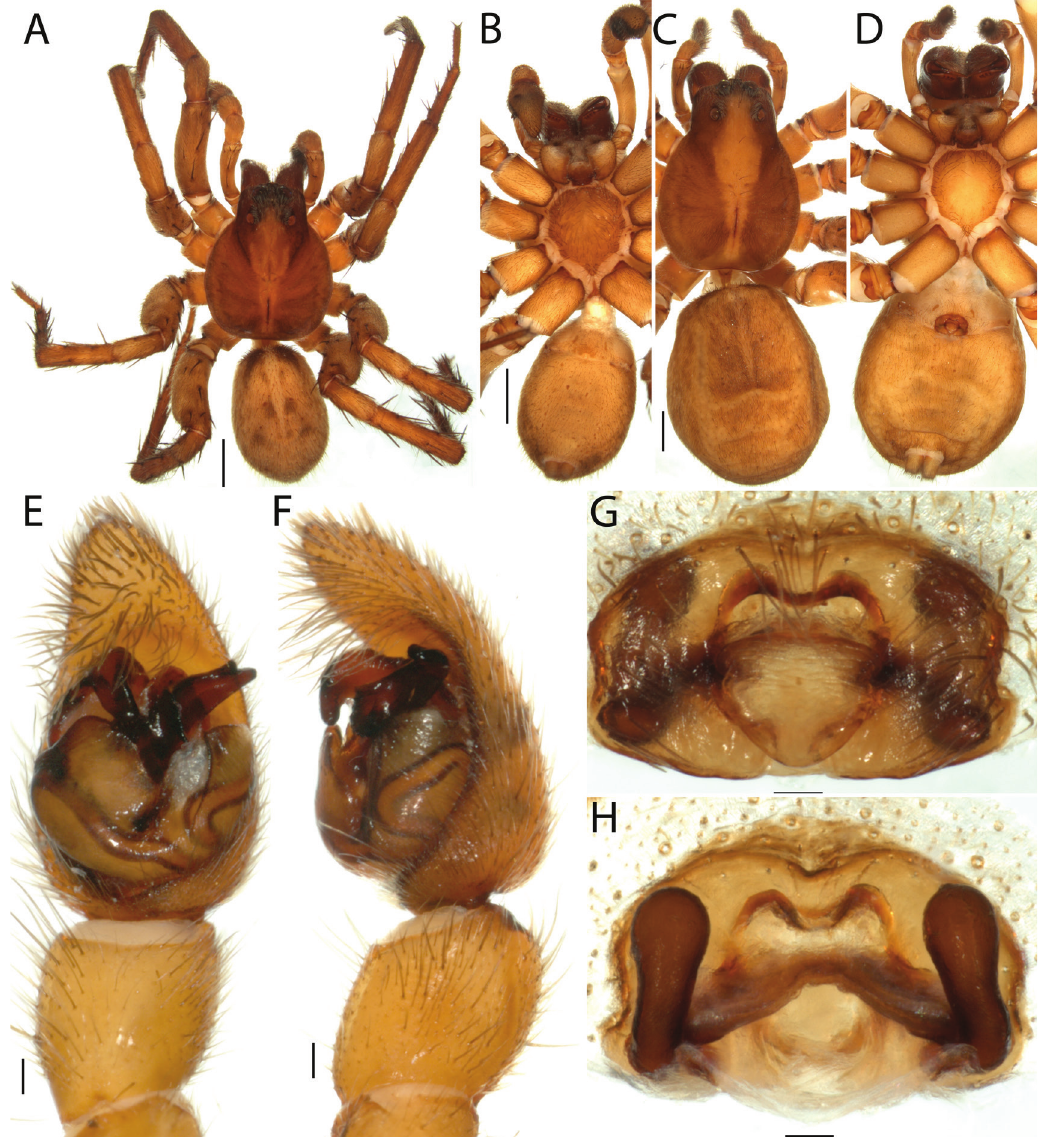
Figure 20. Aroria gloriosa (Rainbow, 1920), male and female (AM KS84008): A , male habitus, dorsal view; B , male habitus, ventral view; C , female habitus, dorsal view; D , female habitus, ventral view; E, male pedipalp, ventral view; F , male pedipalp, retrolateral view; G , epigyne, ventral view; H , epigyne, dorsal view. Scale bars: habitus 1.0 mm; pedipalp, epigyne 0.1